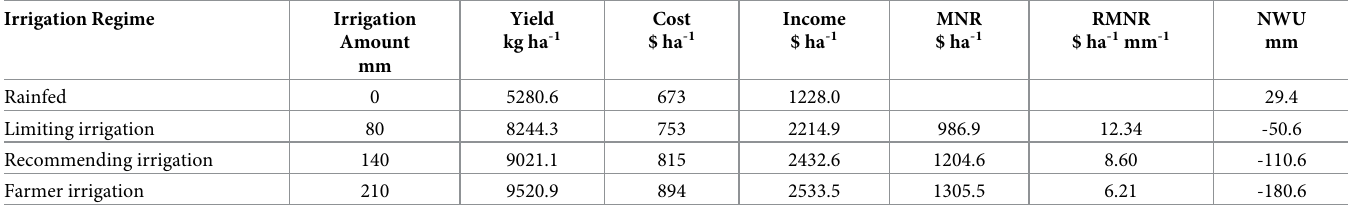
Table 4. Economic costs for different irrigation regimes over 22